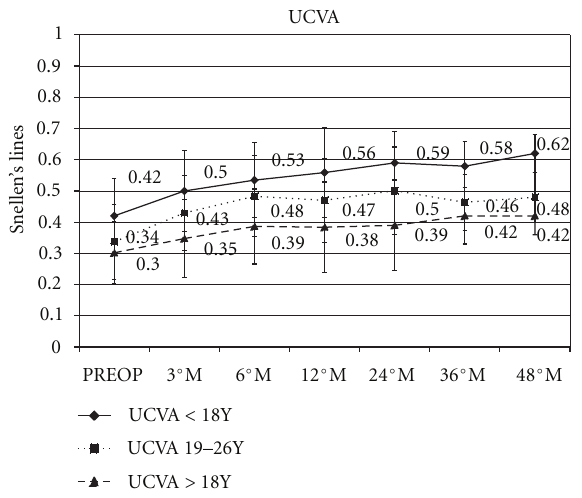
Figure 1: Graph showing visual performance during followup. After cross-linking, uncorrected visual acuity (UCVA) in patients ≤ 18 years showed a mean gain of +0.14, +0.17, +0.16, and +0.2 Snellen lines at 12, 24, 36, and 48 months of follow-up, respectively; in patients between 19 and 26 years showed a mean gain of +0.13, +0.16, +0.12, and +0.14 Snellen lines at 12, 24, 36, and 48 months of followup, respectively; and in patients ≥ 27 years showed a mean gain of +0.08, +0.09, +0.12, and +0.12 Snellen lines at 12, 24, 36, and 48 months followup, respectively.